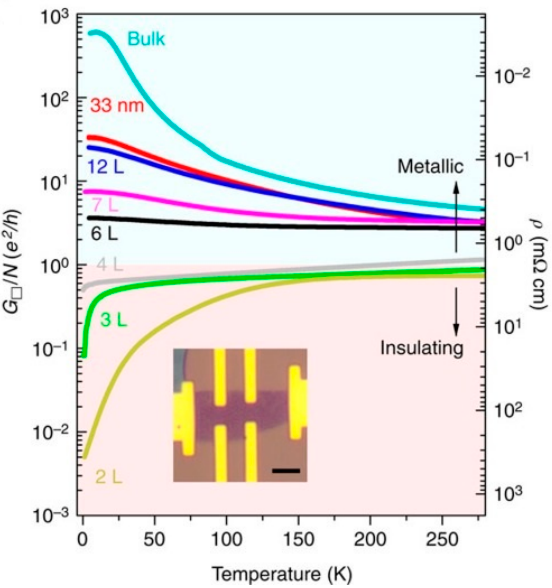
Figure 5. Metal–insulator transition in thin WTe 2 layer [38].